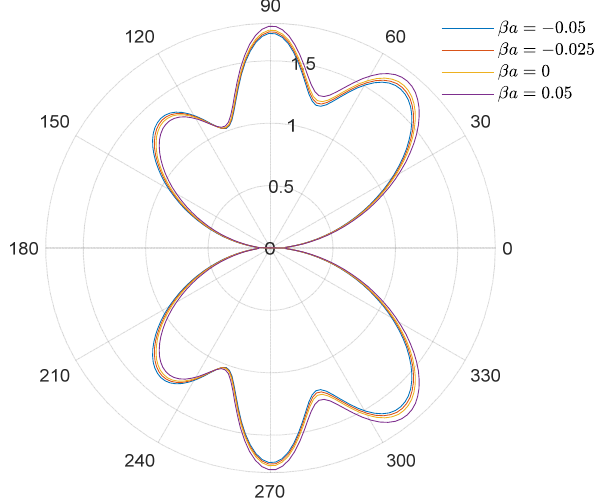
Figure 3. Polar graph of DSCC around the elliptical opening with ka = 0.1 and m = 1/4.